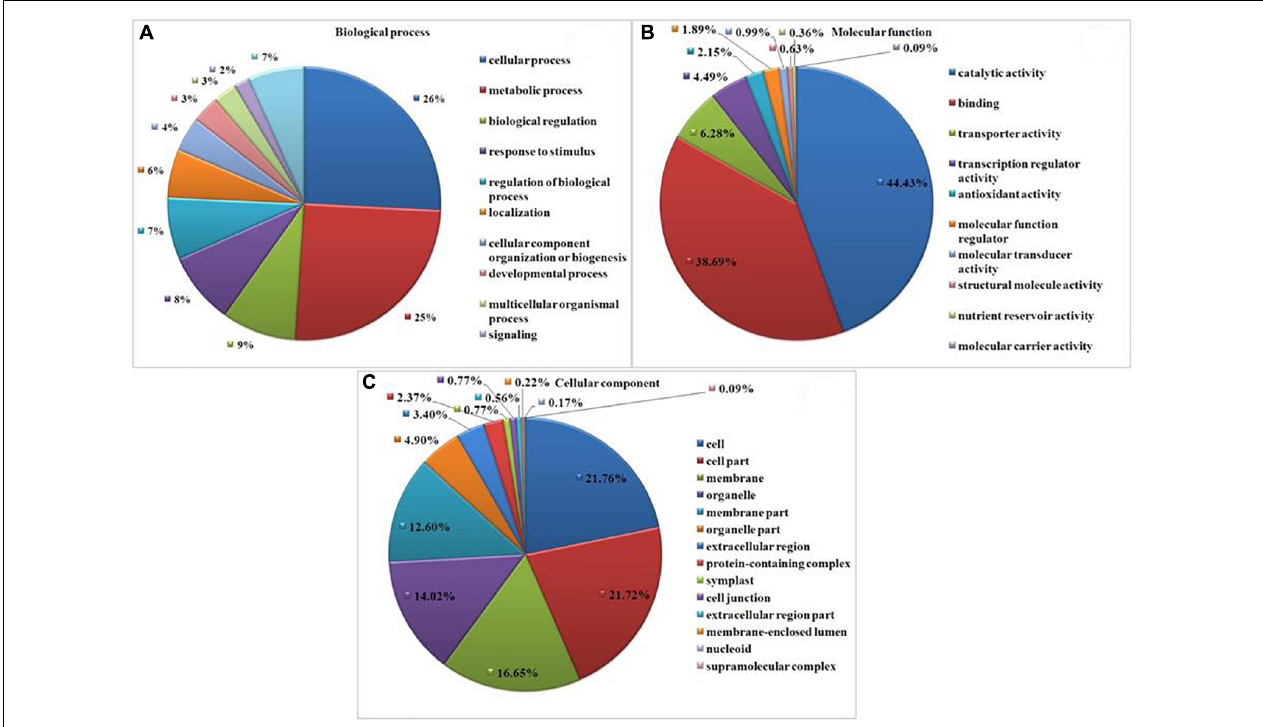
FIGURE 4 | Gene Ontology (GO)-based functional annotation of genes present in the T. harzianum -treated drought-stressed rice genome vs. drought-stressed rice. (A) Biological process domains, (B) molecular function domain, and (C) cellular process